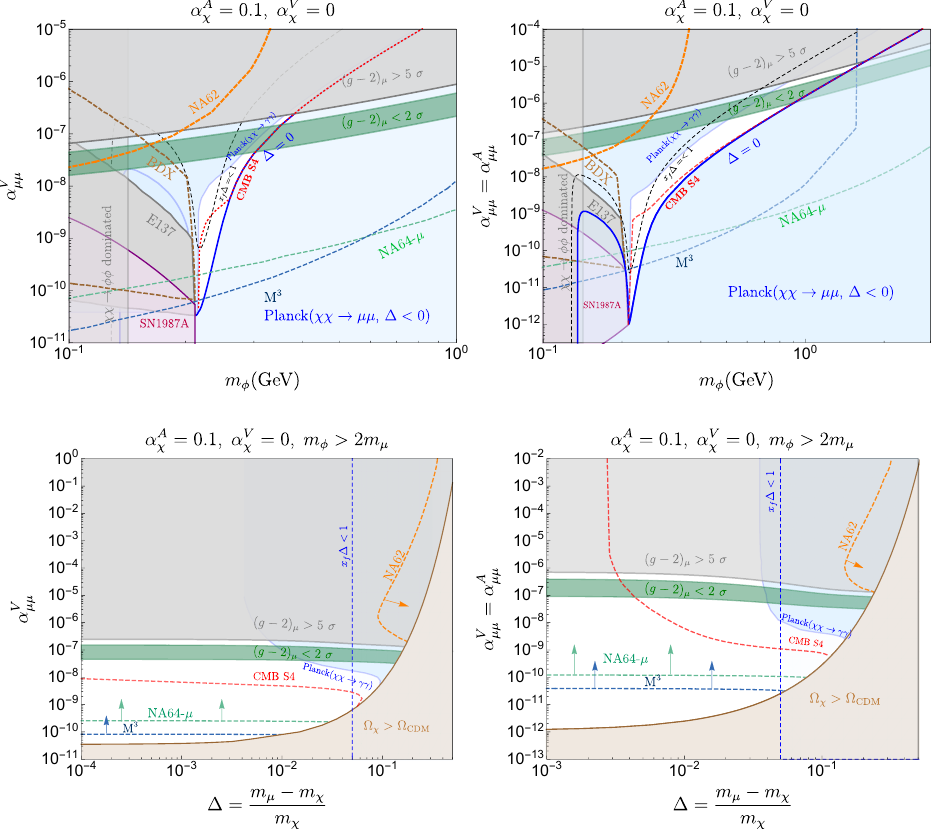
Figure 1 . Theoretical and experimental constraints on Forbidden DM annihilations into µ + µ − . We show constraints from the E137 electron beam-dump experiment [70], excess cooling of SN1987A [71], measurements of the muon anomalous magnetic moment [39–41], and Planck bounds on annihilations at the recombination epoch [56]. We include projections for CMB-S4 [72] and fu- ture beam-dump experiments from BDX [73], M 3 [14, 67], NA62 [69, 74], and NA64- µ [75–77]. In the upper (lower) row, we choose ∆ ( m φ ) to match the observed relic density in the white region. Ordinary annihilations into pairs of mediators set the relic density in the shaded gray region. In the brown area, Forbidden DM has a larger abundance than the observed DM